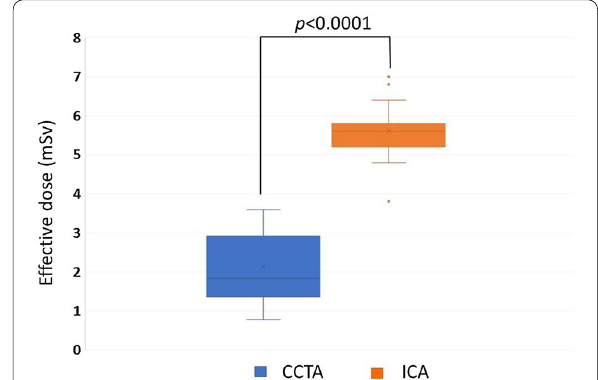
Table 1 Radiation dose from coronary CTA (CCTA) and invasive diagnostic coronary angiography (ICA)